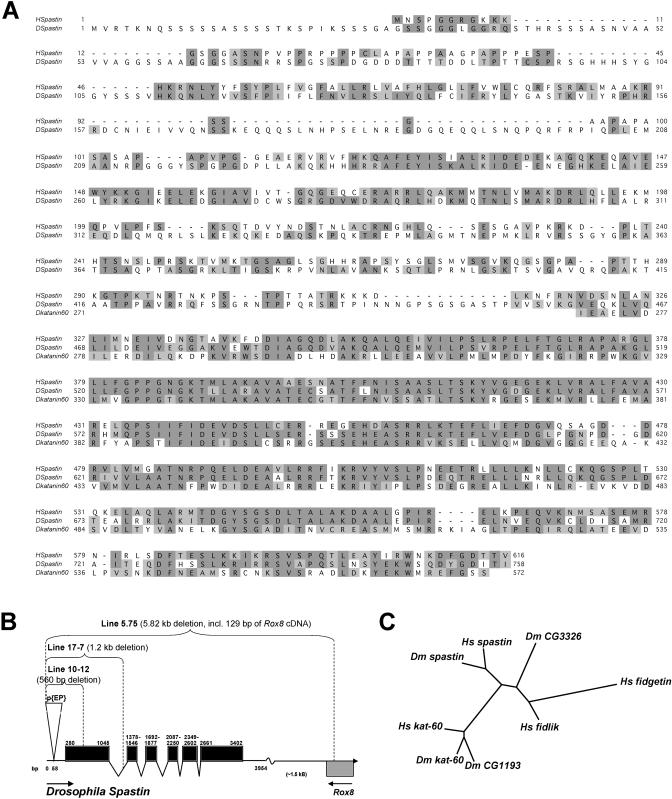

Drosophila Spastin: Sequence Alignment and Gene Map(A) Clustal alignment of complete D. melanogaster and H. sapiens Spastin amino acid sequences and the AAA region of Drosophila Katanin-60. Identical and similar residues are highlighted in dark and light gray, respectively.(B) Map of the Drosophila
spastin gene, including exons (black boxes) and introns, the position of the T32
EP insertion (nucleotide 58 of the 5′ UTR), and the regions deleted by imprecise excision in lines 10-12, 17-7, and 5.75. The 3′ end of the adjacent Rox8 gene is also shown. Arrows indicate direction of transcription.(C) Unrooted phylogenetic tree generated by the “neighbor” algorithm, showing relationships between the AAA domains of Spastins and their close relatives in human and fly. Dm CG3326 is the counterpart of the human fidgetin/fidlik gene pair, while CG1193 probably encodes a second fly ortholog of human Katanin-60. In the mouse, fidgetin mutations produce inner ear defects that cause head-shaking and circling behaviors (Cox et al. 2000).